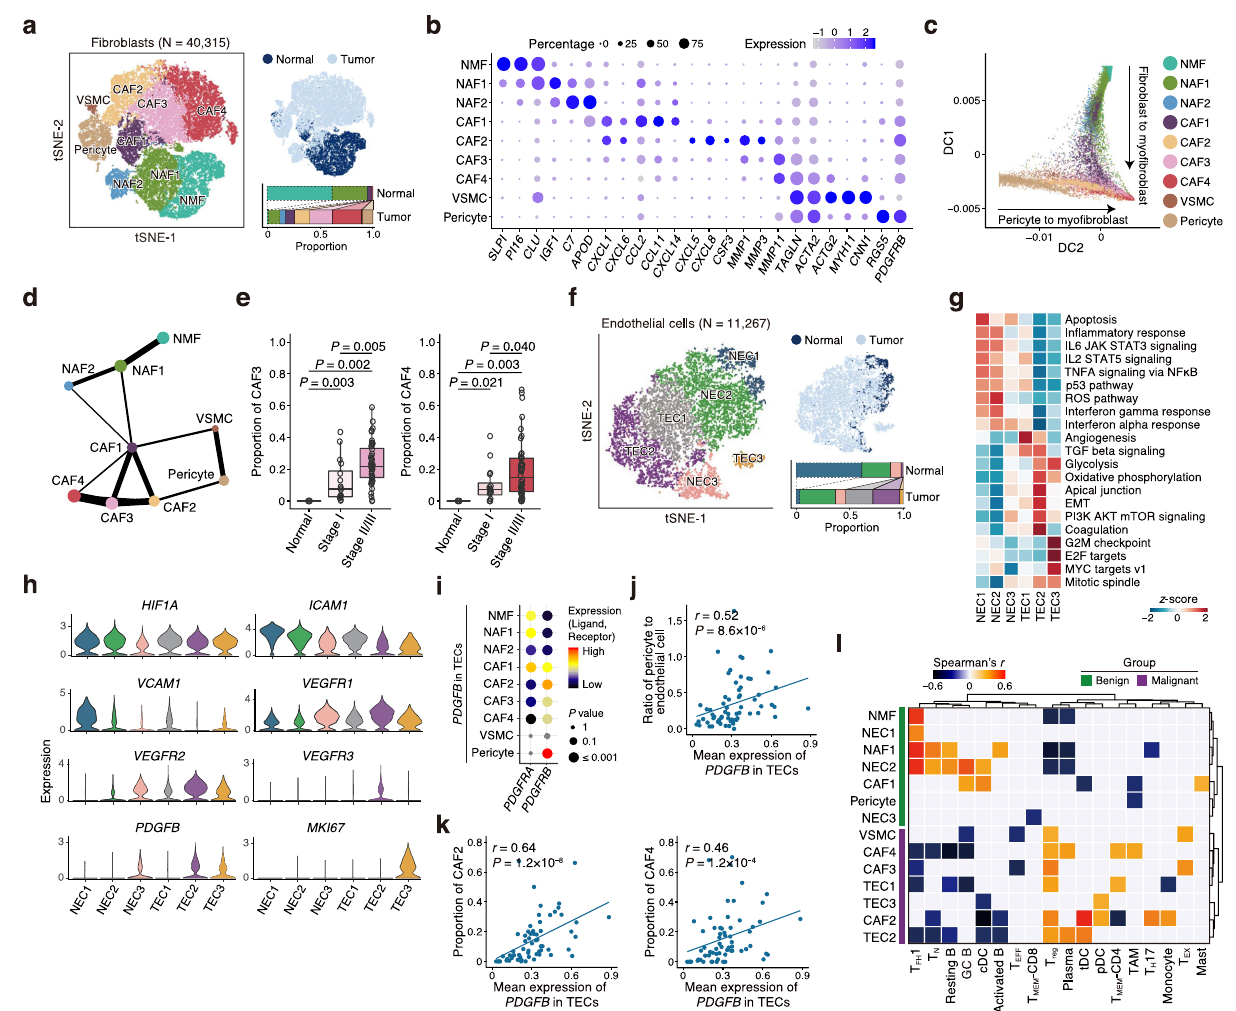
Fig. 5 Characterization of speci fi c trajectories for fi broblast and pericyte differentiation. a tSNE plots of 40,315 fi broblasts, colored by cell type ( left ) and tissue type ( top right ). The proportions of cell types in normal and tumor tissues are shown on the bottom right. See Fig. 1b legend for the line indications. b Dotplot showing expression status of selected fi broblast markers in each cell cluster. c Diffusion map of fi broblasts. Dot represents single-cell colored by cluster. The two main differentiation branches are indicated with solid arrows. d PAGA analysis of fi broblast subtypes. Line thickness corresponds to the level of connectivity. e Boxplots showing proportion of CAF3 ( left ) and CAF4 ( right ) in normal tissues ( N = 4), stage I ( N = 16) and stage II/III ( N = 44) tumors (two-sided Wilcoxon test). Boxplots show the median (central line), the 25 – 75% interquartile range (IQR) (box limits), the ±1.5 times IQR (Tukey whiskers), and all data points, among which the lowest and the highest points indicate minimal and maximal values, respectively. f tSNE plots of 11,267 endothelial cells, colored by cell type ( left ) and tissue type ( top right ). The proportions of cell types in normal and tumor tissues are shown on the bottom right. See Fig. 1b legend for the line indications. g Heatmap showing differences in pathway activities scored per cell by GSVA between different endothelial clusters. h Violin plots showing the expression distribution of selected genes in the endothelial cell clusters. i Dotplot showing selected ligand – receptor interactions. The means of the average expression level of PDGFB in TECs and interacting receptor, PDGFRA and PDGFRB , in fi broblast subtypes are indicated by color. j Spearman ’ s correlation between the mean expression of PDGFB in TECs and the ratio of pericyte to endothelial cell in all samples. k Spearman ’ s correlations between the mean expression of PDGFB in TECs and the proportion of CAF2 ( left ) and CAF4 ( right ) in all samples, respectively. l Clustered heatmap showing two-sided Spearman correlation coef fi cients between proportions of immune and nonimmune cell subtypes in tumor samples. P < 0.05 is used as the cutoff